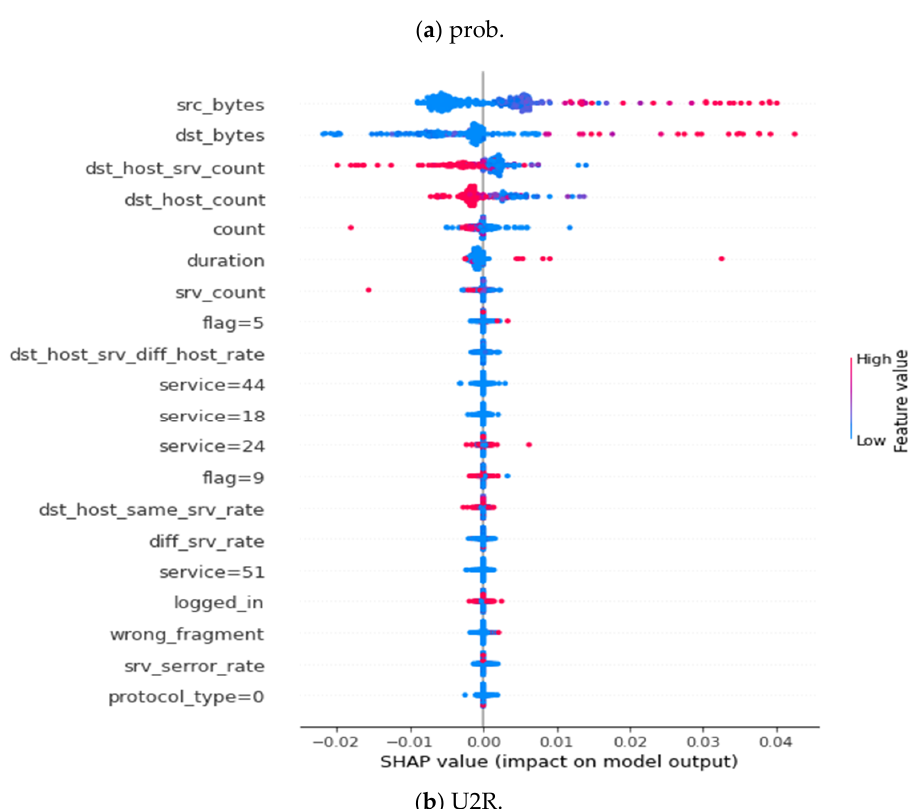
Figure A7. Top 20 important features of ( a ) prob and ( b ) U2R.